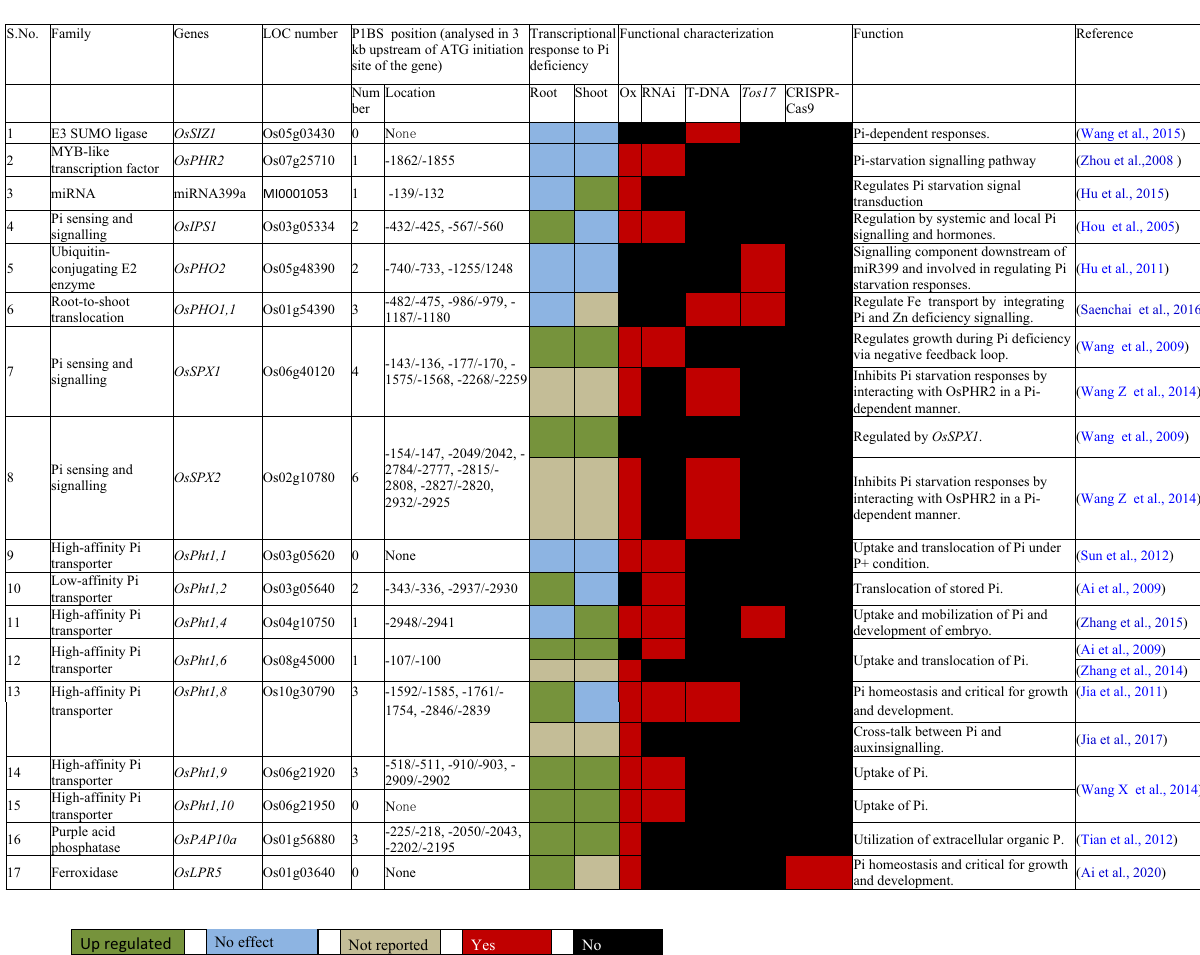
Uptake and translocation of Pi. Pi homeostasis and critical for growth (Jia et al., 2011) and development.transporter 1754, -2846/-2839 Cross-talk between Pi and auxinsignalling. Uptake of Pi. Uptake of Pi. Utilization of extracellular organic P. (Tian et al., 2012) Pi homeostasis and critical for growth and